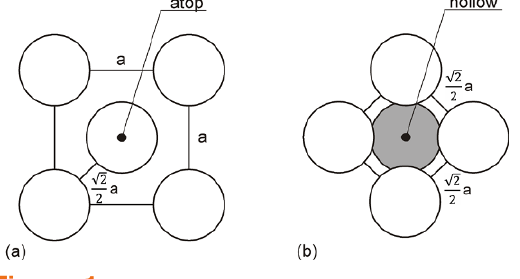
Figure 1. Schematic illustration of the investigated (a) planar and (b) pyramidal clusters that model the (100) surfaces of the alloys and the neat metals. Light circles represent the atoms of the surface layer, while dark circle marks the subsurface atom. The lattice constant, a, taken from Table 3. Two characteristic positions of the H-atom adsorption also